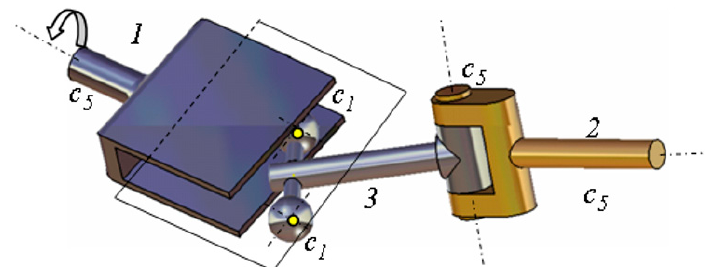
Figure 8. The bipod contact between the centers of spheres from the element 3 (the intermediate part between the shafts 1 and 2) and the symmetry plane of the channel. The higher pairs are denoted c 1 and the revolute pairs are denoted c 5